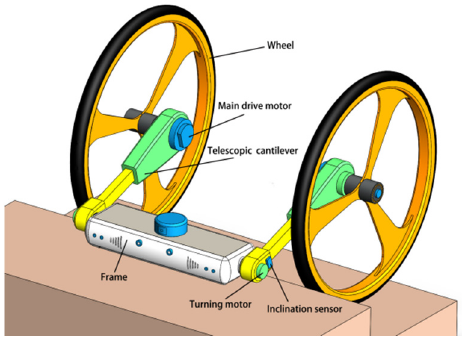
Figure 1. The “4R+2P” structure model of the robot.